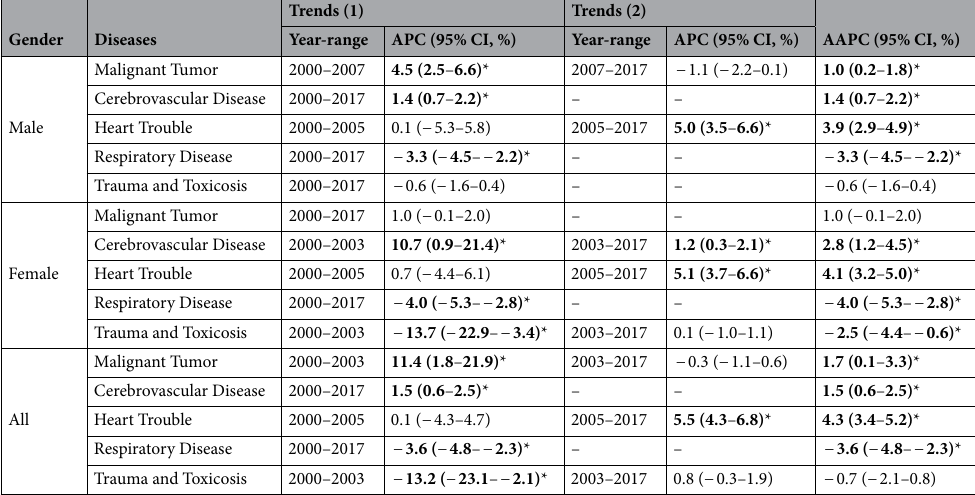
Table 2. The trends of the top 5 causes of death in rural areas of China from 2000 to 2017. APC Annual Percent Change; AAPC Average Annual Percent Change; CI confidence interval. Significant values are in bold. *Indicates that AAPC or APC is significantly different from zero at the alpha = 0.05